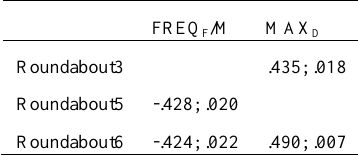
Significant correlations (r, p-value) summary between selective attention and eye fixations